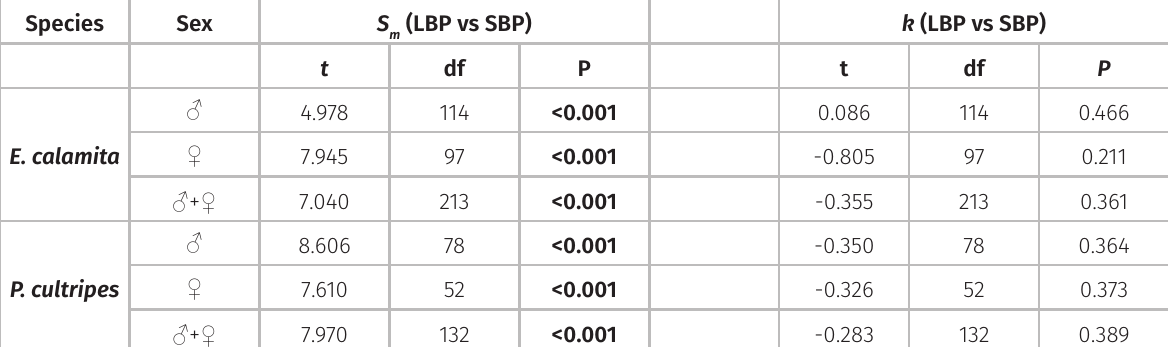
Table V. T-student test for differences between Large-Bodied (LBP) and Small-Bodied populations (LBP) in estimated parameters from von Bertalanffy equations, for body growth (SVL) of Epidalea calamita and Pelobates cultripes . S = average maximal body size, k = growth coefficient, defining the slope of the growth curve. Significant m values are highlighted in